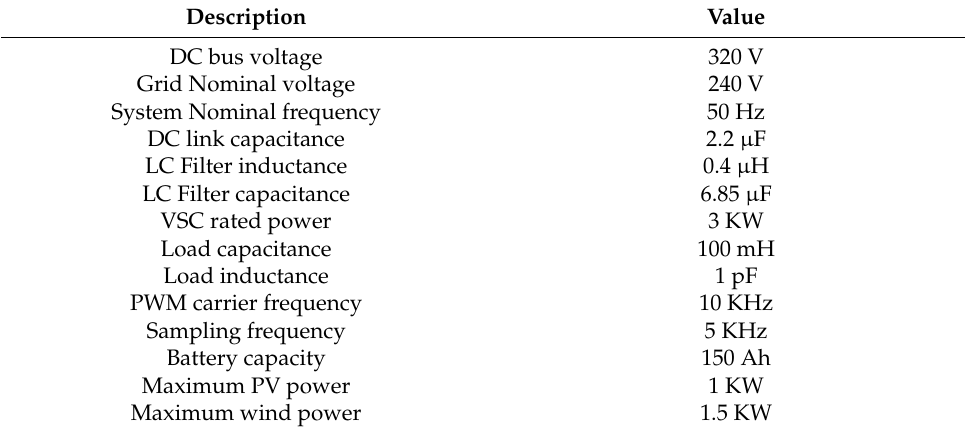
Table 2. MG system